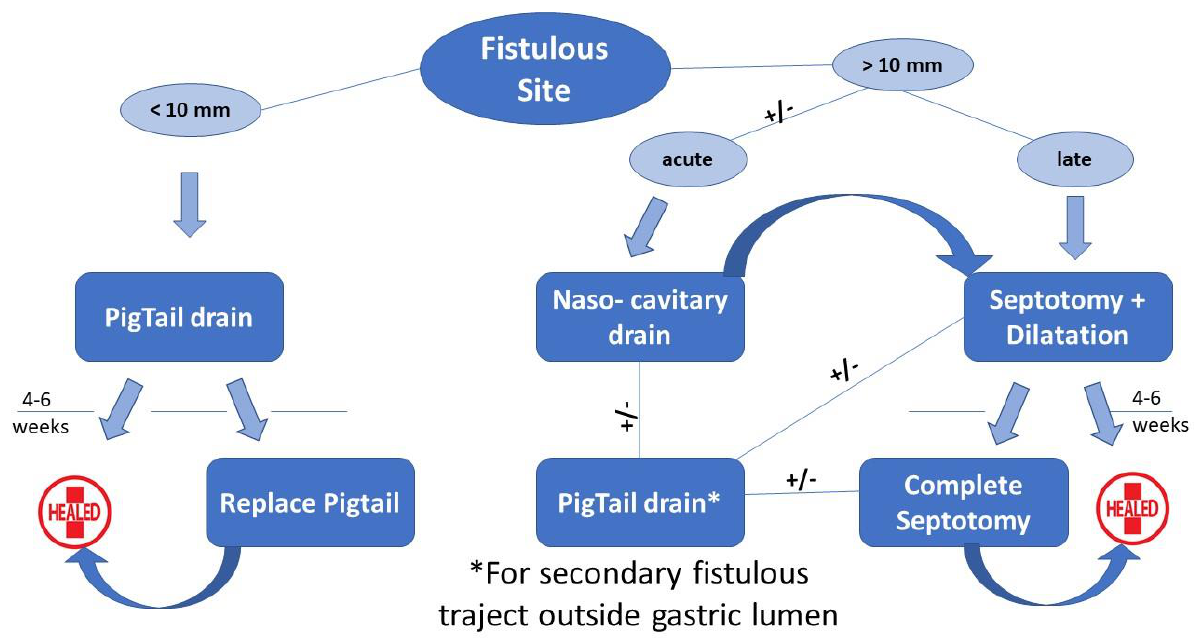
Figure 1. Algorithm of endoscopic treatment of leaks after LSG.